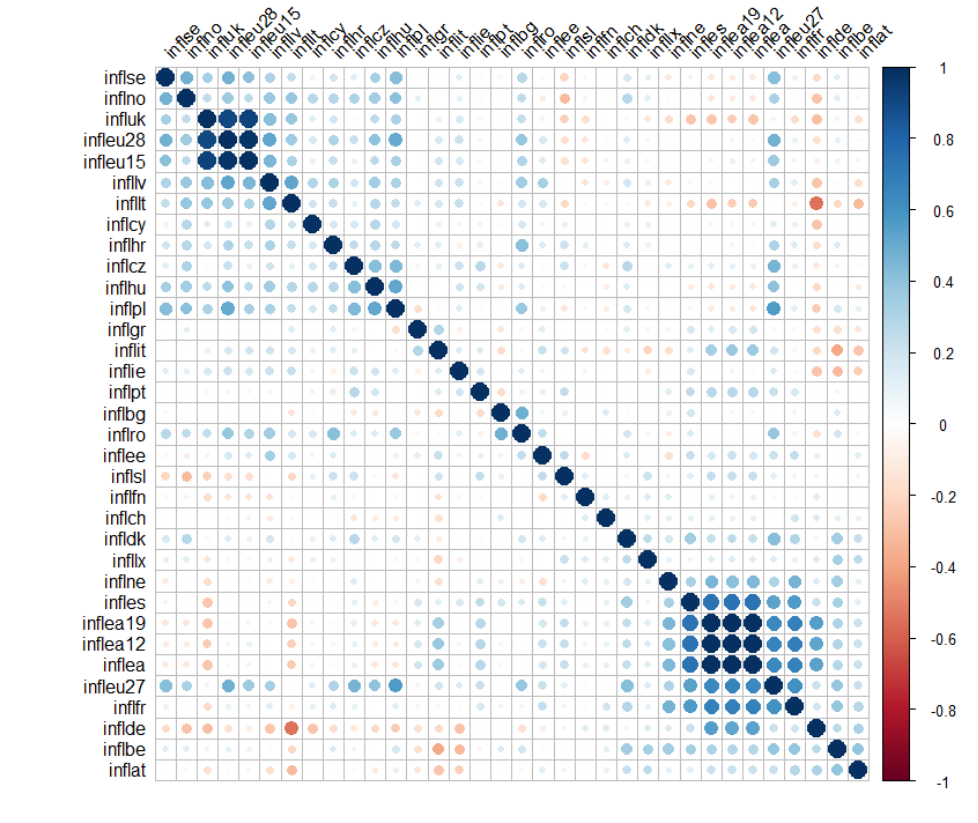
Figure 4. Heat map matrix of Pearson correlation coefficients between inflation rates for all the entities in the sample. Source: own elaboration with data from Eurostat. Note: the labels denominate the inflation (infl) plus the two-letter country codes (e.g. at –